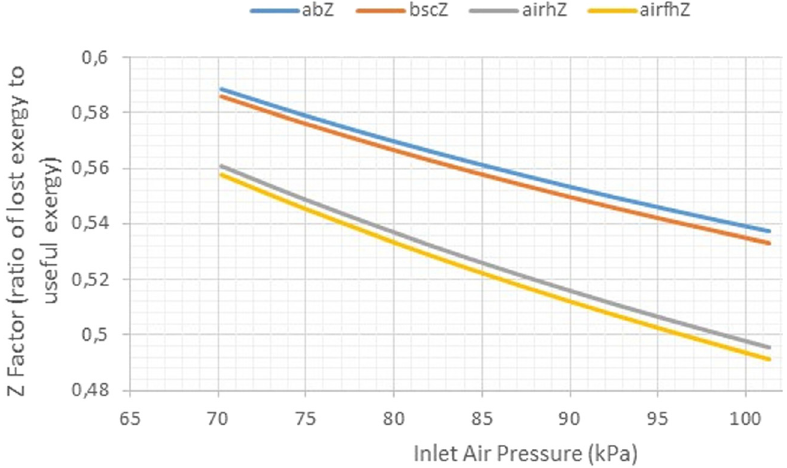
Figure 5: Variation of the Z factor ( ratio of lost exergy to useful exergy ) with inlet air ( atmospheric ) pressure for ab, bsc, airh, and airfh cogeneration